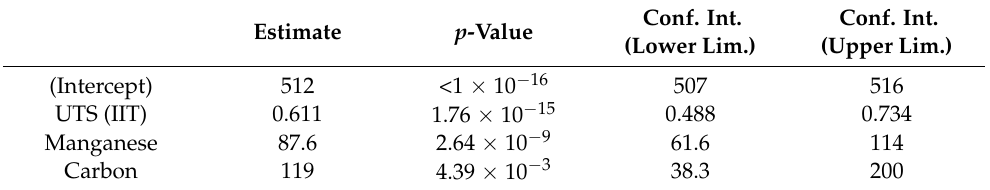
Table 5. UTS IIT + Composition model; regression coefficients and model parameters (coefficients appear in Equation (11)).